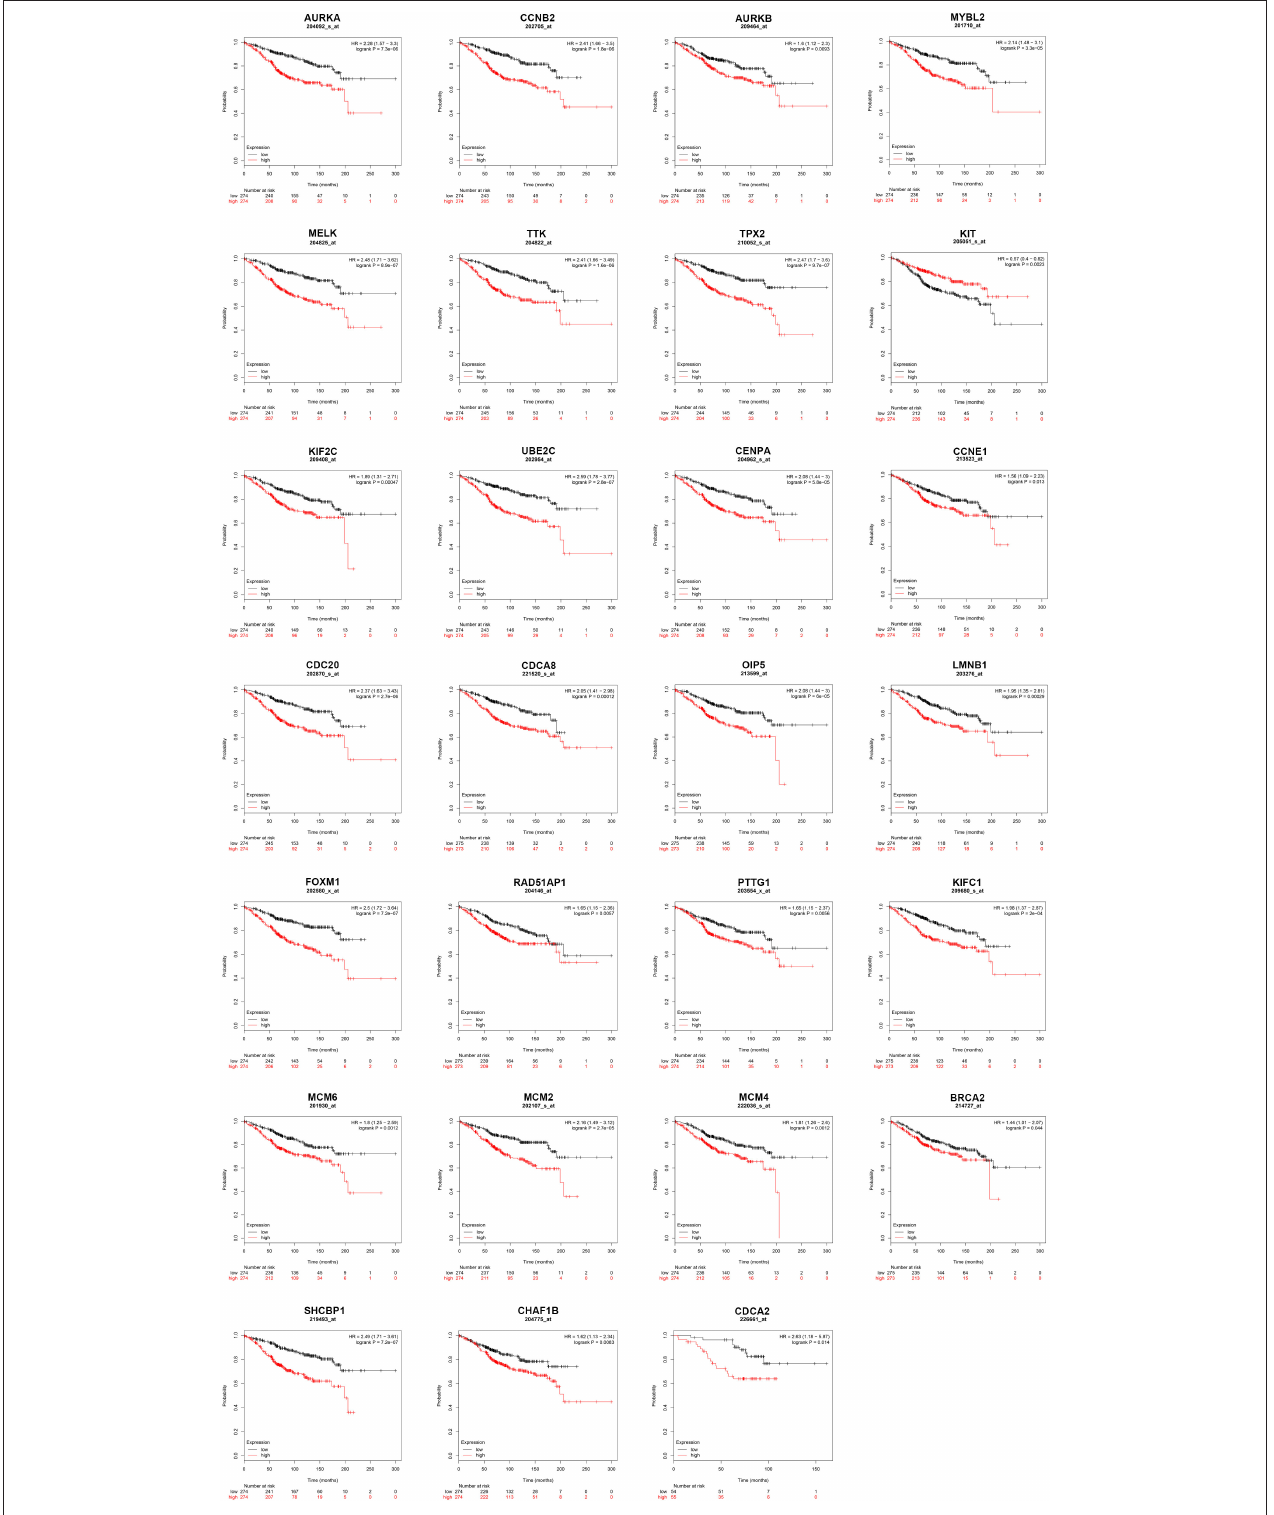
FIGURE 3 | The prognostic values of key genes ( AURKA, CCNB2, AURKB, MYBL2, MELK, TTK, TPX2, KIT, KIF2C, UBE2C, CENPA, CCNE1, CDC20, CDCA8, OIP5, LMNB1, FOXM1, RAD51AP1, PTTG1, KIFC1, MCM6, MCM2, MCM4, BRCA2, SHCBP1, CHAF1B, and CDCA2 ) in ER α positive breast cancer determined by Kaplan-Meier plotter